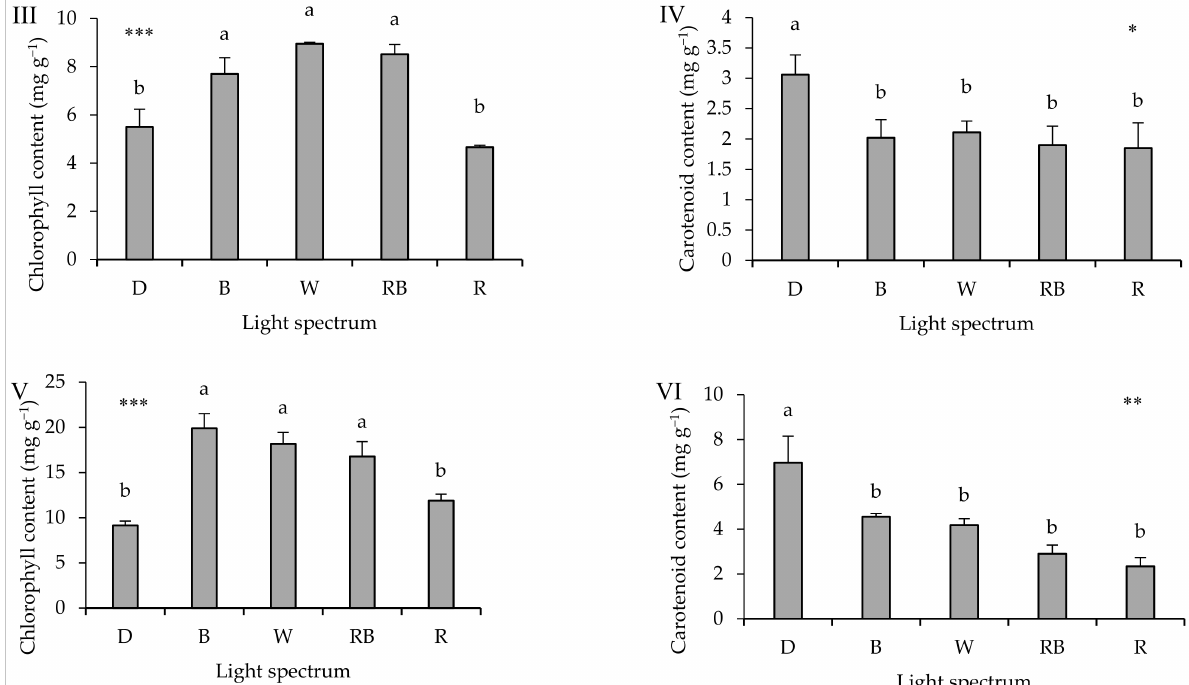
Figure 3. Chlorophyll and carotenoid contents of rootstock cotyledon ( I , II , respectively), scion cotyledon ( III , IV , respec- tively), and scion leaf ( V , VI , respectively) in grafted watermelon seedlings exposed for 12 days to either darkness (D) or different light quality regimes [blue (B), white (W), red and blue (RB), as well as red (R); see spectrum in Supplementary Figure S3]. Photosynthetic photon flux density was 20 ± 1 µ mol m − 2 s − 1 during the first 2 days, and 50 ± 1 µ mol m − 2 s − 1 during the following days. Nine plants per treatment were assessed. Different letters indicate that values are significantly different at p < 0.01 according to Duncan’s multiple range tests. Bars represent SEM. Significance at the 0.05, 0.01, 0.001 and 0.0001 probability levels are indicated by *, **, *** and ****,